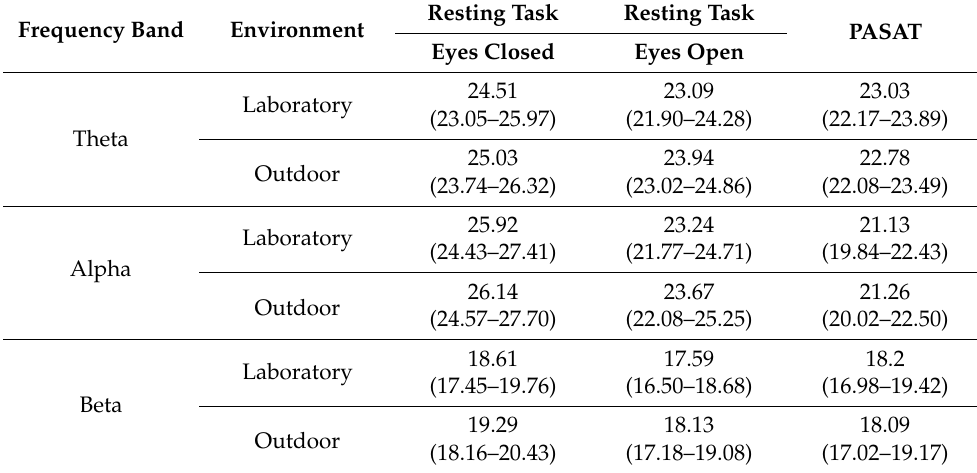
Table 6. Average EEG power